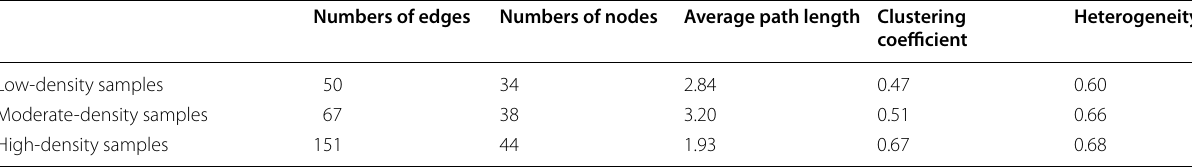
Table 5 Network properties in low-, moderate-, and high-density samples Numbers of edges Numbers of